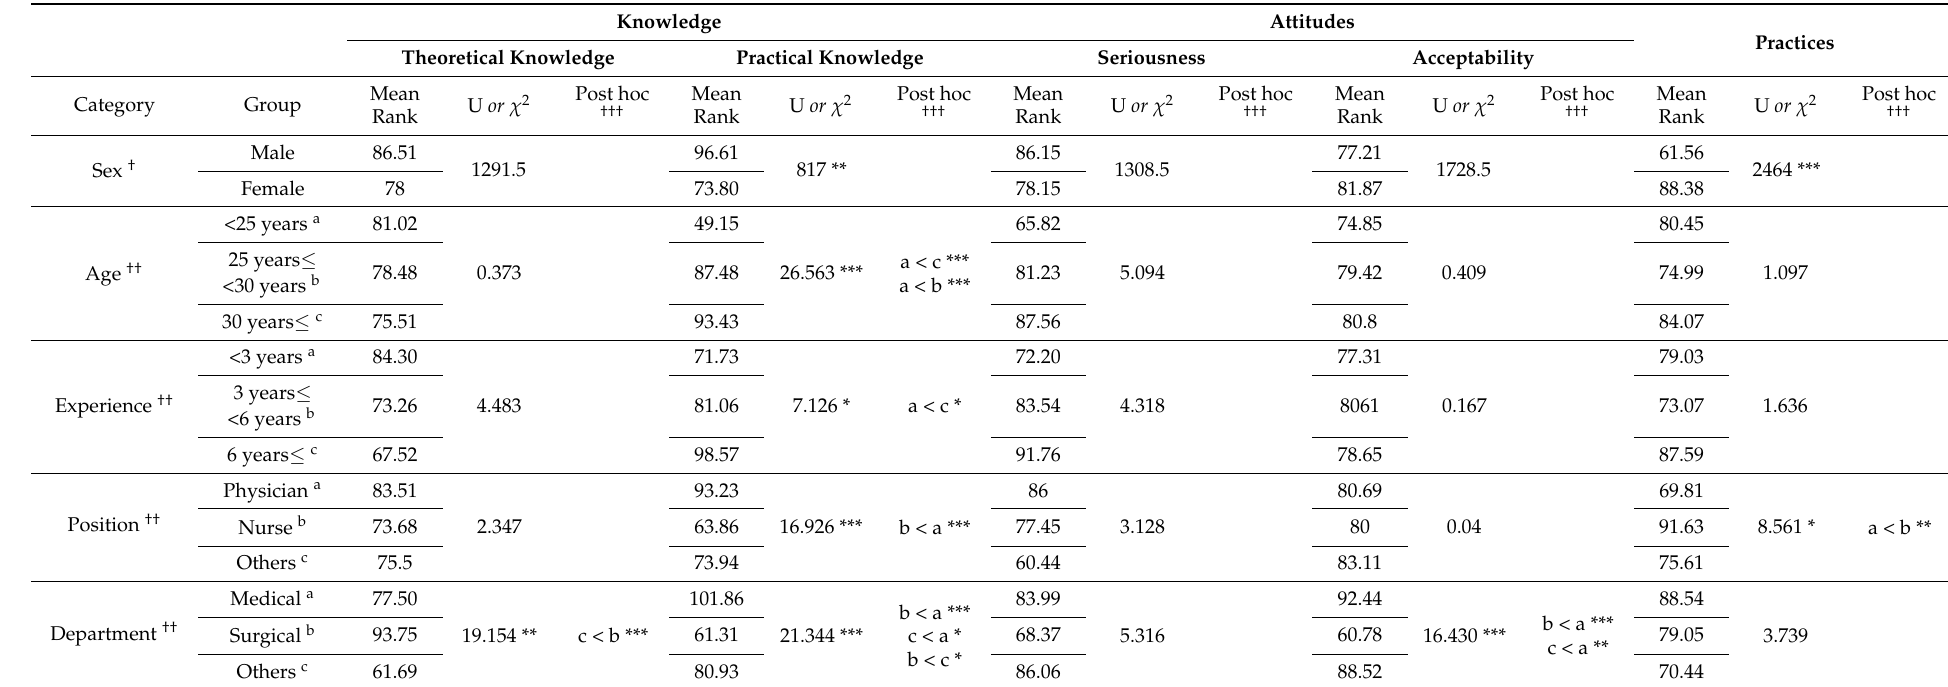
Table 4. Group differences in knowledge, attitudes and practices ( n =